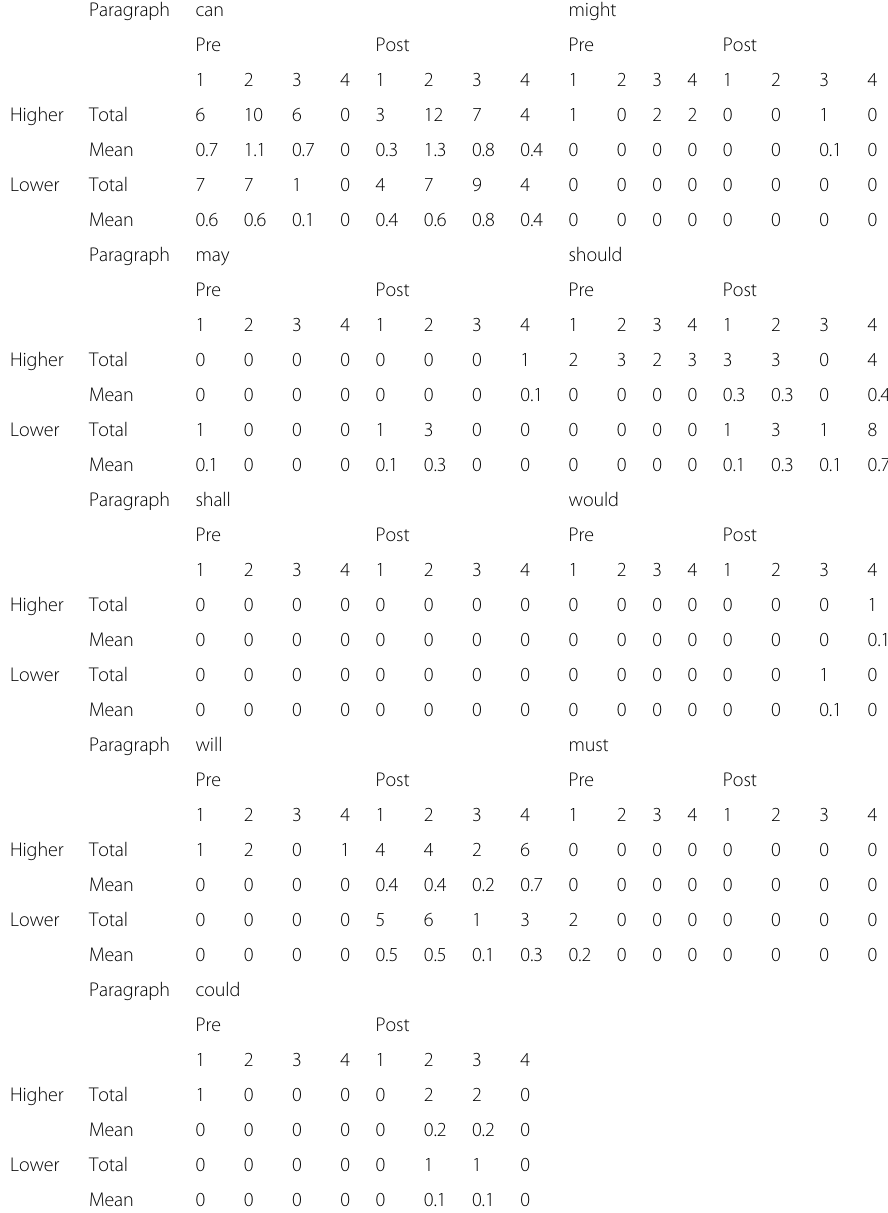
Table 6 Frequency Analysis of the Modal Auxiliaries of the Pre-and Post-Genre